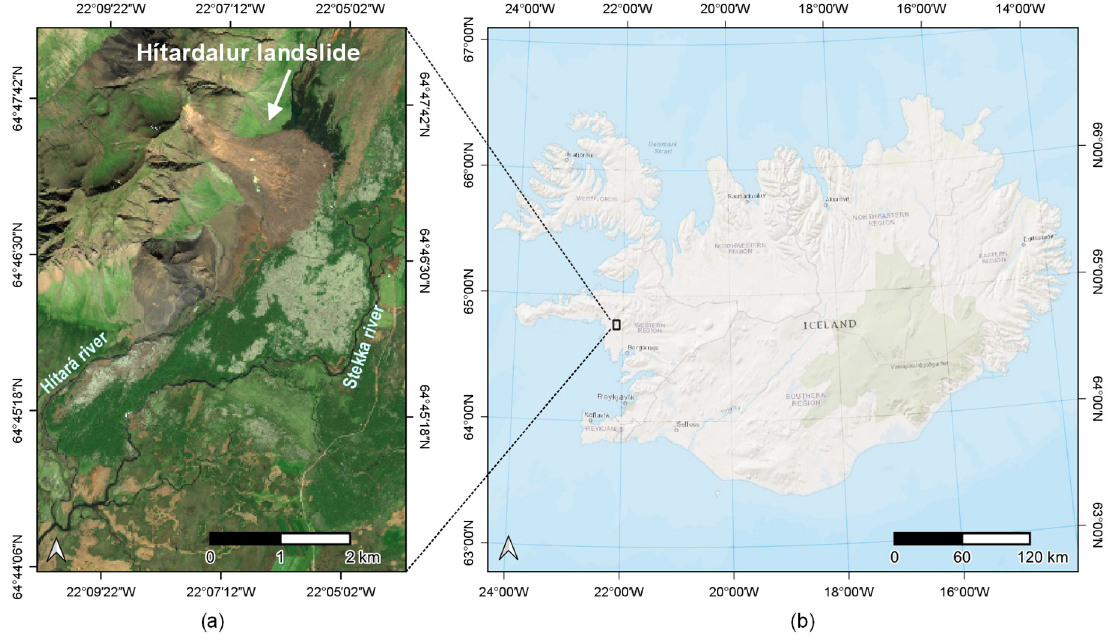
Figure 1. ( a ) The study area around the Hítardalur landslide shown on a Sentinel-2 image acquired on 17 July 2018 and ( b ) its location in western Iceland; background data © ESRI. 17 July 2018 and ( b ) its location in western Iceland; background data ©